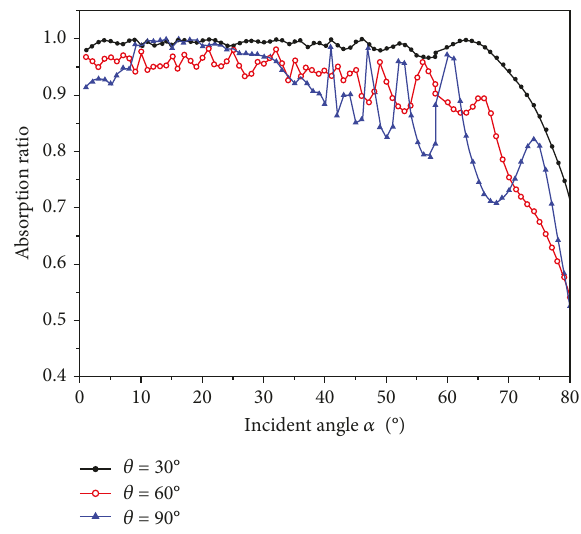
Figure 10: Absorptivity varying curve of sinusoidal surface structure along with incident